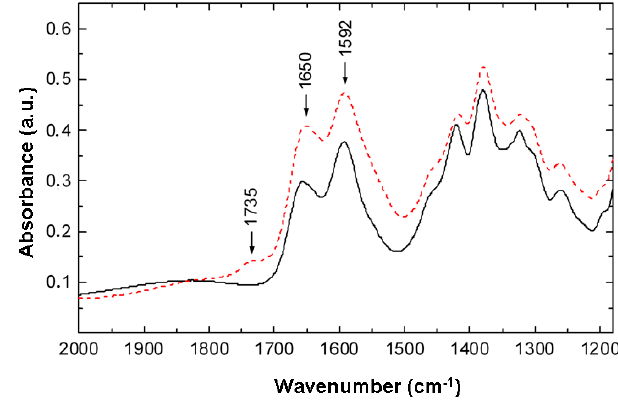
Figure 7. Partial absorbance spectra of the chitosan film before (solid black curve) and after (dashed red curve) the EBP-treatment in oxygen media in the range 1180–2000 cm − 1 .